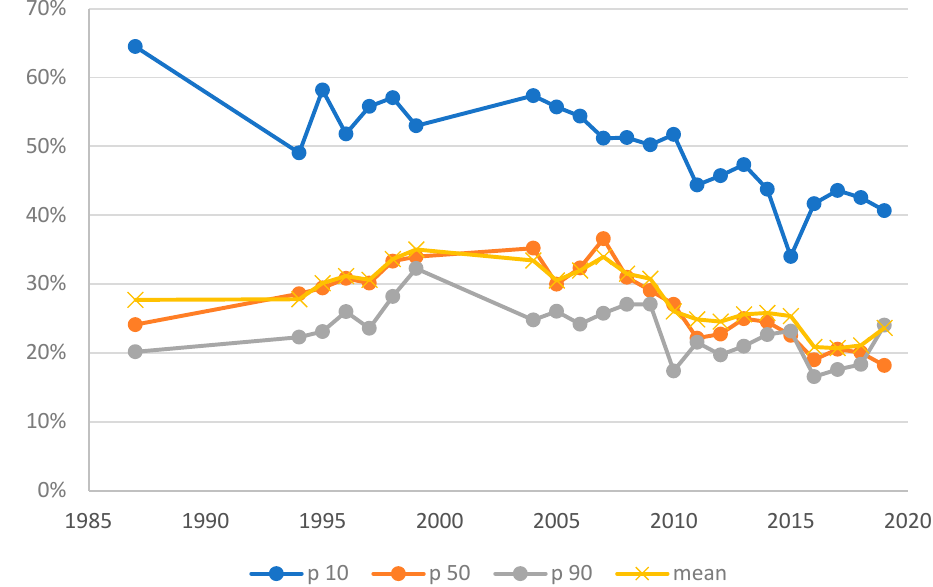
Figure 1. The gender gap in weekly earnings, expressed as a proportion of male earnings. Source: